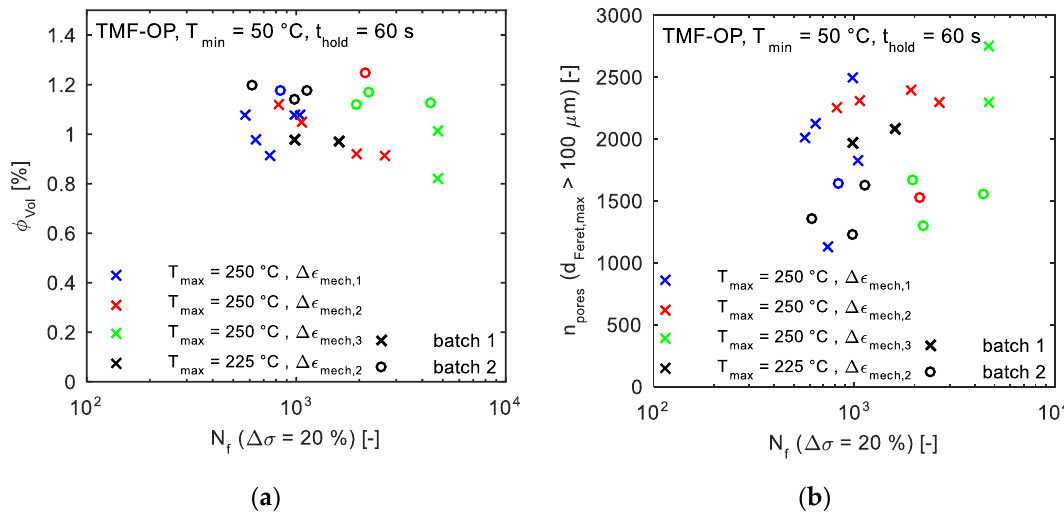
Figure 8. Global pore parameters vs. lifetime: ( a ) Pore volume fraction; ( b ) Number of pores with a maximum Feret diameter larger than 100 μm.